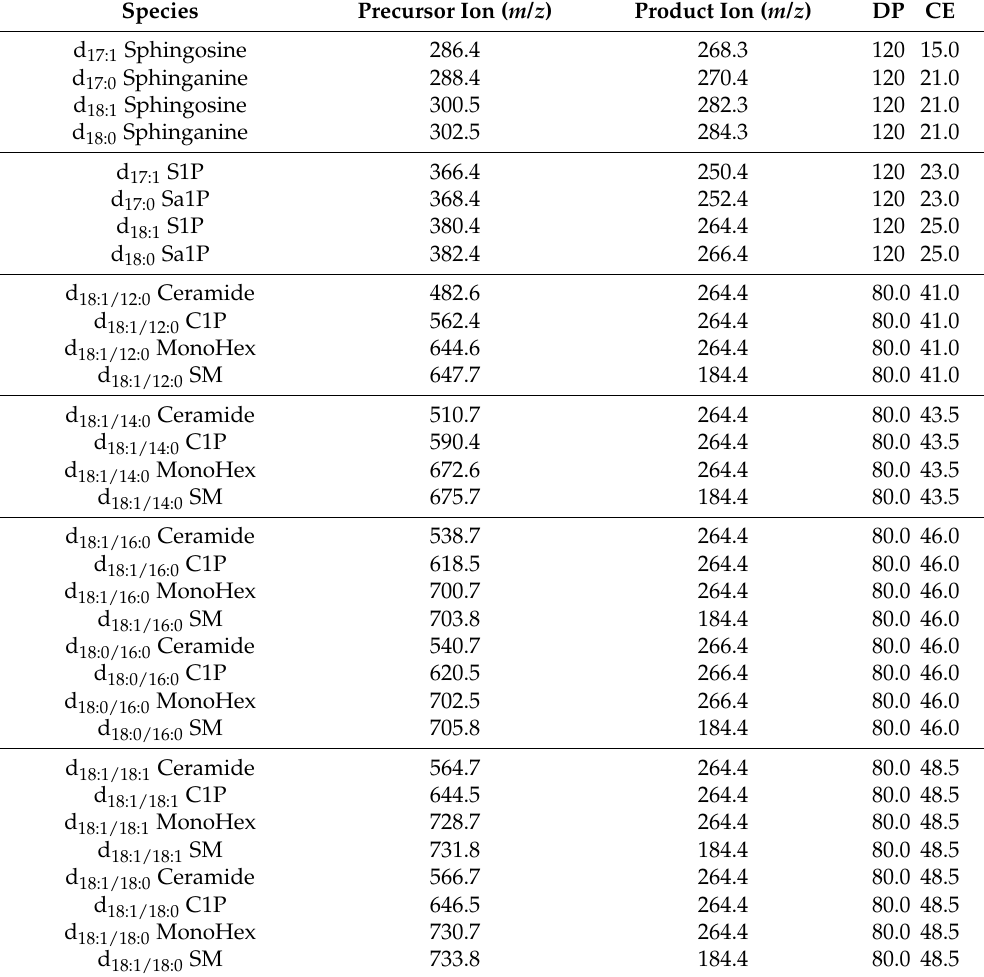
Table A1. MRM Transitions monitored for the investigated sphingolipid